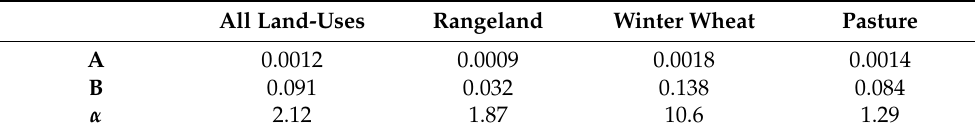
Table 1. Values of vegetation parameters used in the semi-empirical model. All Land-Uses Rangeland Winter Wheat